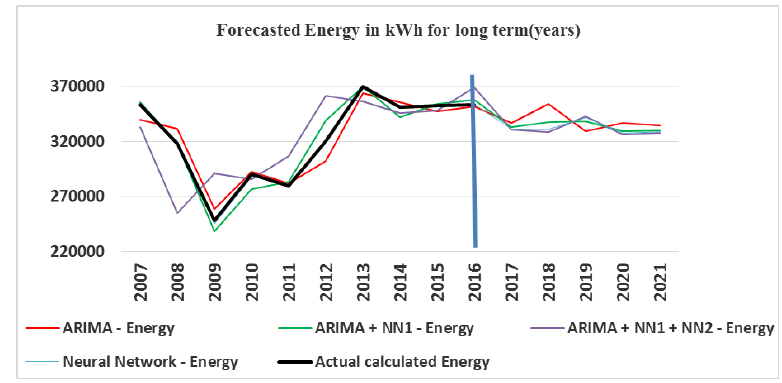
Figure 20. Average annual energy Predicted for Long-term forecast (years) in kWh. Source: Authors.